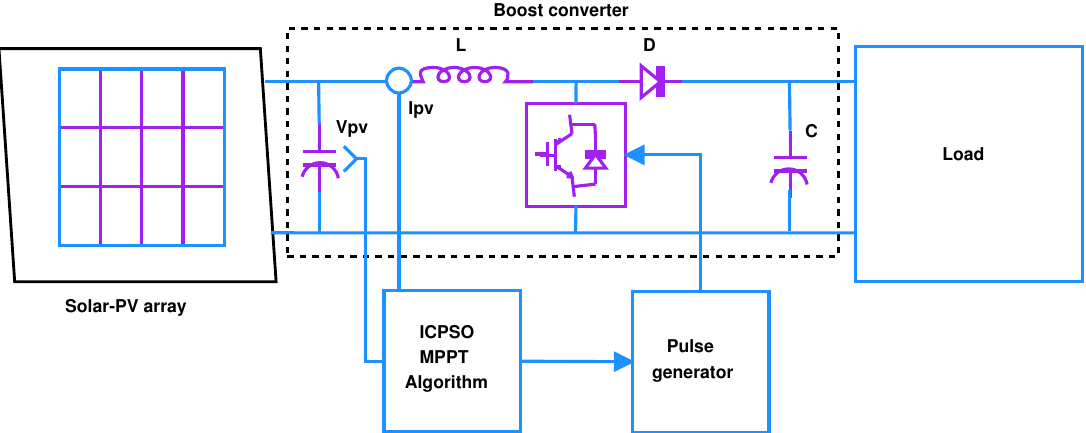
Figure 2. Block diagram of the system under consideration.